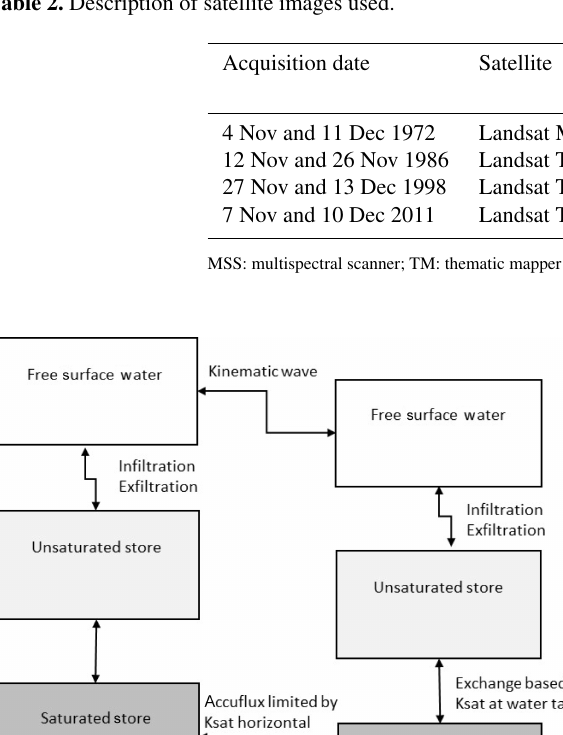
Table 2. Description of satellite images used.